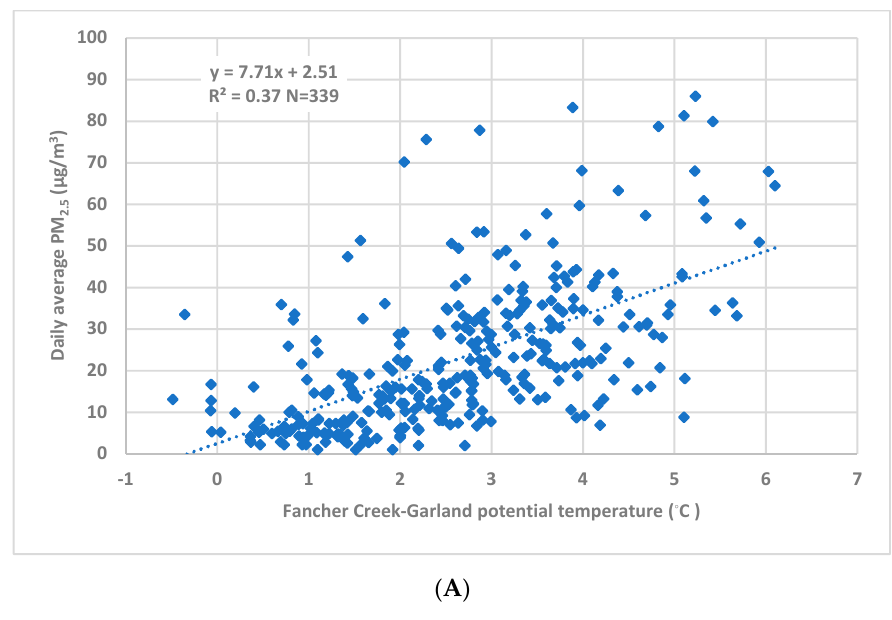
Table 4. Summary of the relationship strength between PM 2.5 and potential temperature gradients for different sites in Fresno. Site Elevation (m) Distance from the Fresno- Garland Site (km)